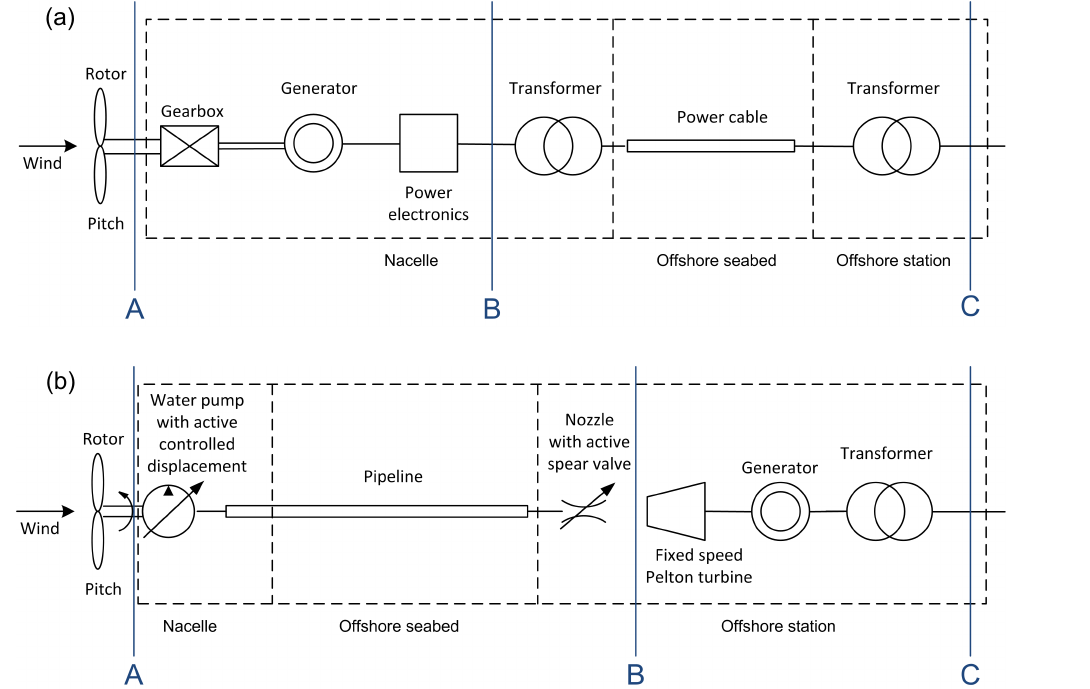
Figure 11. Simplified schematic with the main components involving the energy conversion for a reference offshore wind turbine and the proposed hydraulic concept. (a) NREL reference turbine. (b) Hydraulic